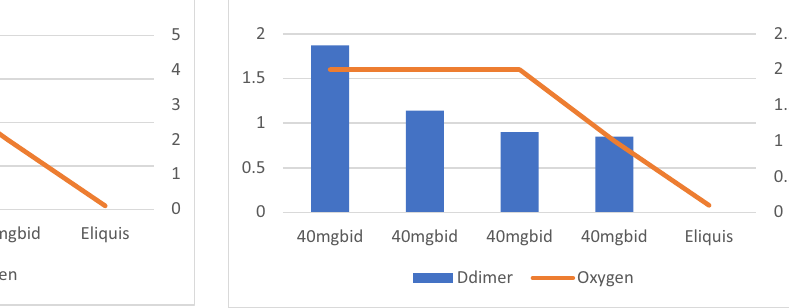
Figure 4: Patient number 4 presented at an early stage requiring nasal canula oxygen and D - dimer level was also moderately low on presentation. The fi gure demonstrates that increase or decrease in D - dimer trends is associated with increasing and decreasing trends of oxygen requirements. This patient was treated with intermediate dose of Enoxaparin ( 40 mg SubQ BID ) .